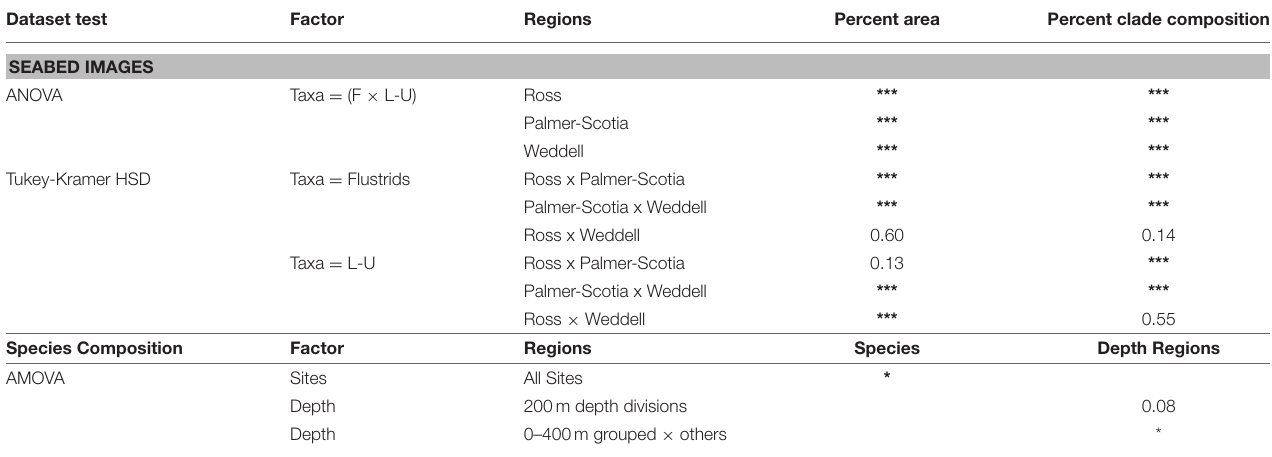
TABLE 2 | Statistical comparisons of seabed image and species composition datasets.